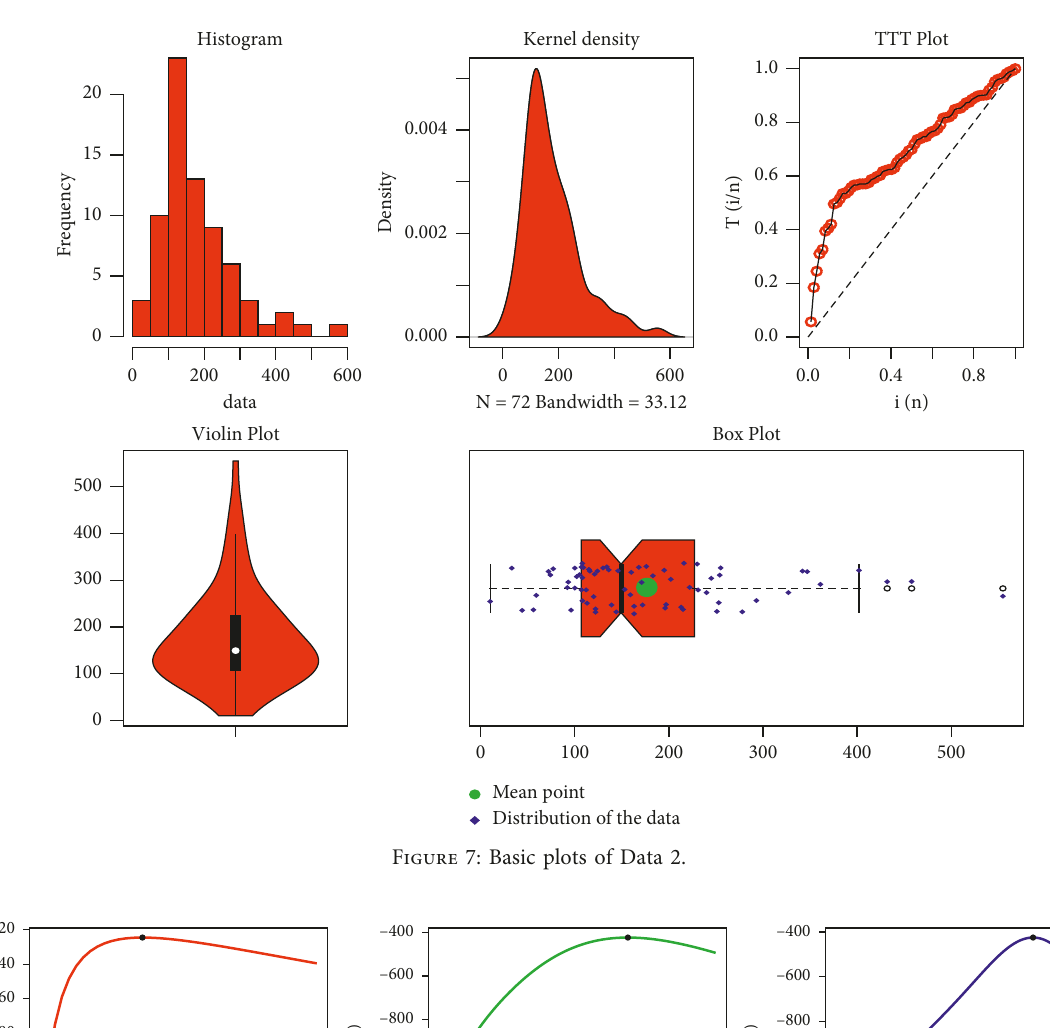
Figure 7: Basic plots of Data 2.